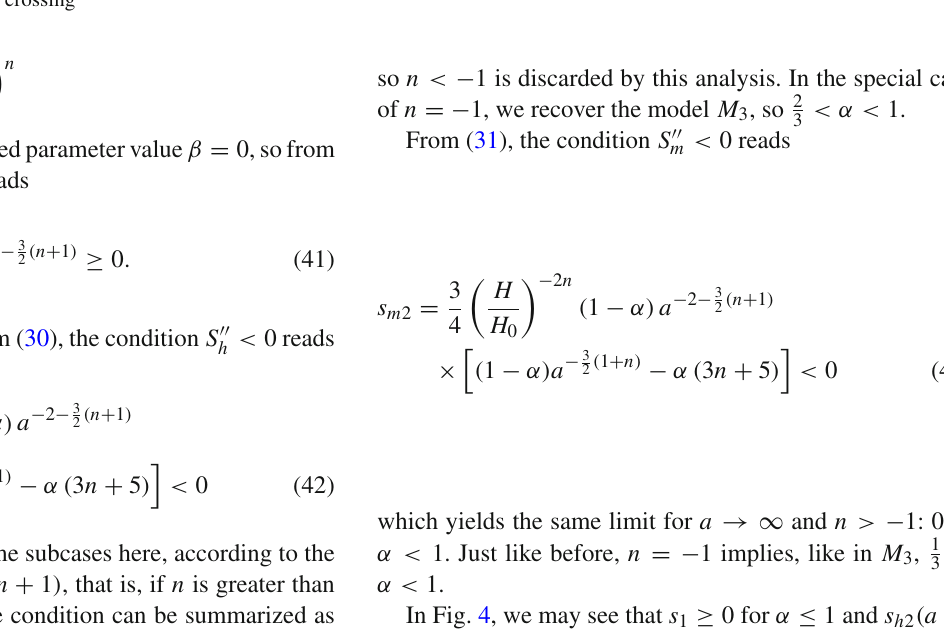
Fig. 4 Model M 4 : s 1 and s h 2 as function of scale factor for some values of (α, n ) . We have used a mixed log-linear scale in order to view both asymptotic behaviour and zero crossing